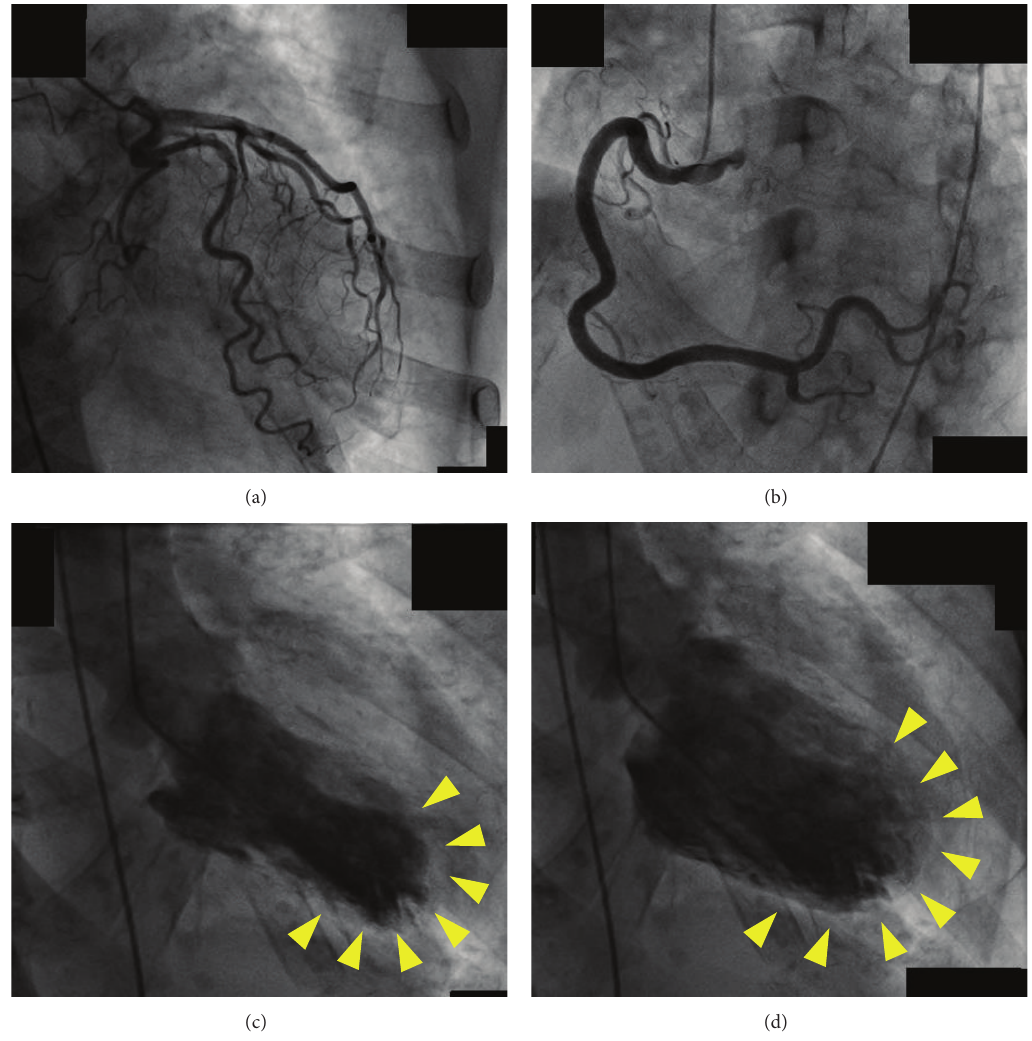
Figure 2: Case 1. Coronary angiography and left ventriculography were performed on the second hospital day. Coronary angiography showed normal right (a) and left (b) coronary arteries and branches. Left ventriculography showed akinesis of the left ventricle apex (arrowheads). (c) End-systolic phase; (d) end-diastolic